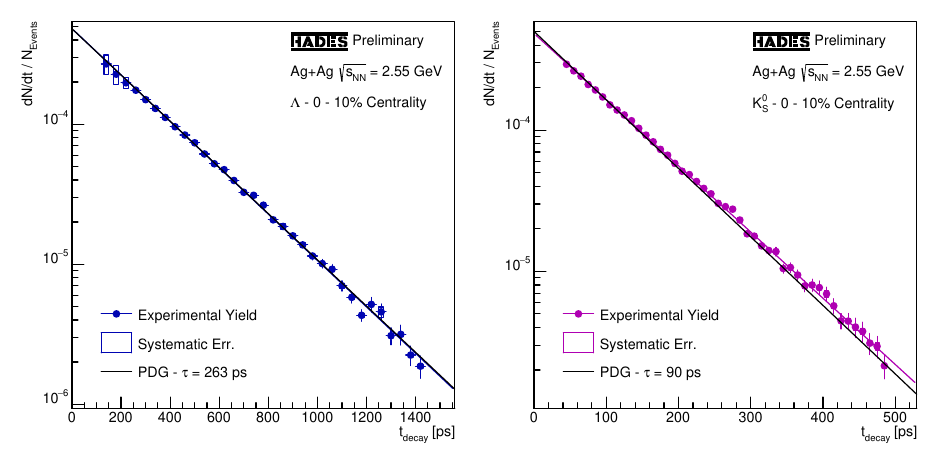
Figure 3. Decay curves of Λ hyperons (left) and K 0 S mesons (right) from the 0-10% most central Ag(1.58A GeV) + Ag events measured by HADES. The colored lines correspond to the exponential fi t functions and the black lines to the PDG literature lifetimes